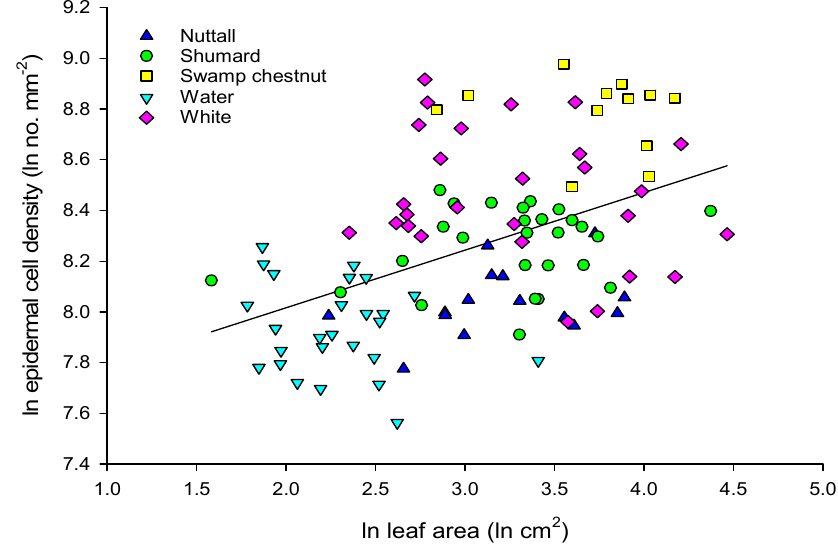
Figure 4. Relationship between the natural log of leaf area (ln cm 2 ) and the natural log of epidermal cell density (ln no. mm − 2 ; r 2 = 0.22; p < 0.0001) for Nuttall (dark blue, up triangle), Shumard (green circle), swamp chestnut (yellow square), water (light blue down triangle), and white oak (magenta diamond).